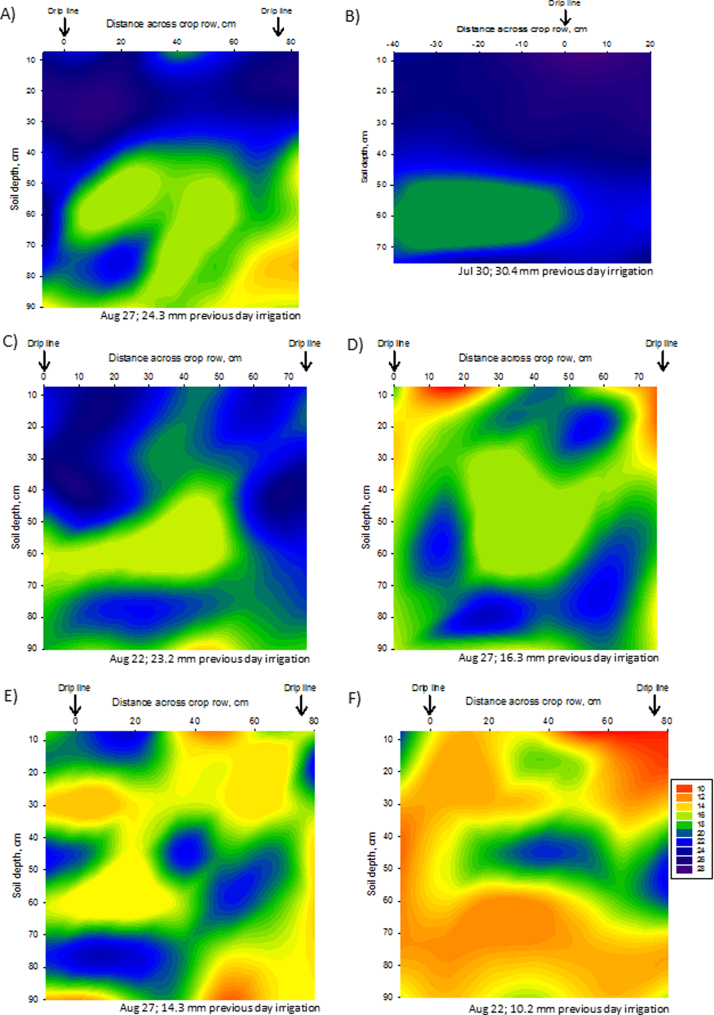
Maps of soil moisture content (percent by volume) measured with a portable time domain reflectometer (TDR, Minitrase, Soil-moisture Equipment Corp, Santa Barbara, CA, USA) in soil pits excavated in 2013 in 100% (A, B), 65% (C, D) and 40% (E, F) ET treatments between two rows down to 1 m. TDR was measured on the face of the wall in 15 cm increments across and down with contour lines created in SigmaPlot 13.0 (Systat Software, Inc., San Jose, CA, USA). Two soil pits, each in two different plots, were measured for the 100% ET target. Measurements after two different irrigations from the same pits were measured for the 65 and 40% ET targets.